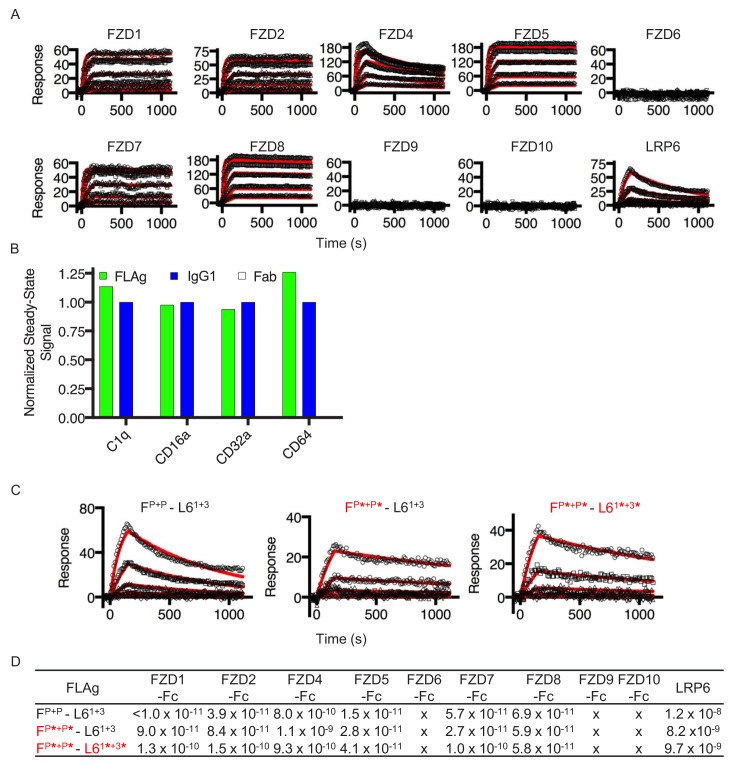
Biophysical properties of FLAgs.(A) Surface plasmon resonance sensograms of FZD recognition by FP+P - L61+3 at concentrations ranging from 100nM- 1.23pM. (B) BLI steady-state measurements for FLAg, IgG and a negative control Fab binding to immobilized mediators of immune effector functions. Signals for FLAg were normalized to the IgG and Fab binding controls, n = 1. (C) Surface plasmon resonance sensograms of LRP6 recognition for the indicated FLAg at concentrations ranging from 100 nM to 1.23 nM. (D) Binding kinetics table of the FLAg constrained as scFv or diabodies to the various FZD isoforms.